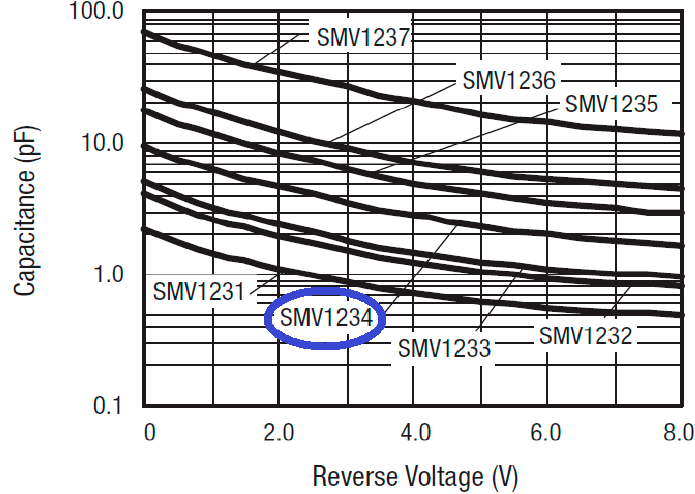
Figure 9. Theoretical reverse biasing voltage performance for several models of Skyworks varactors.